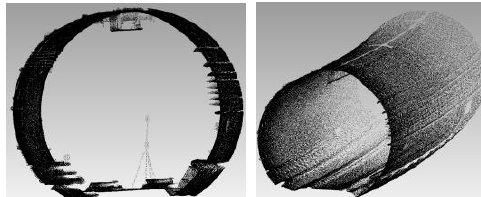
Fig.4 The front and side views of tunnel